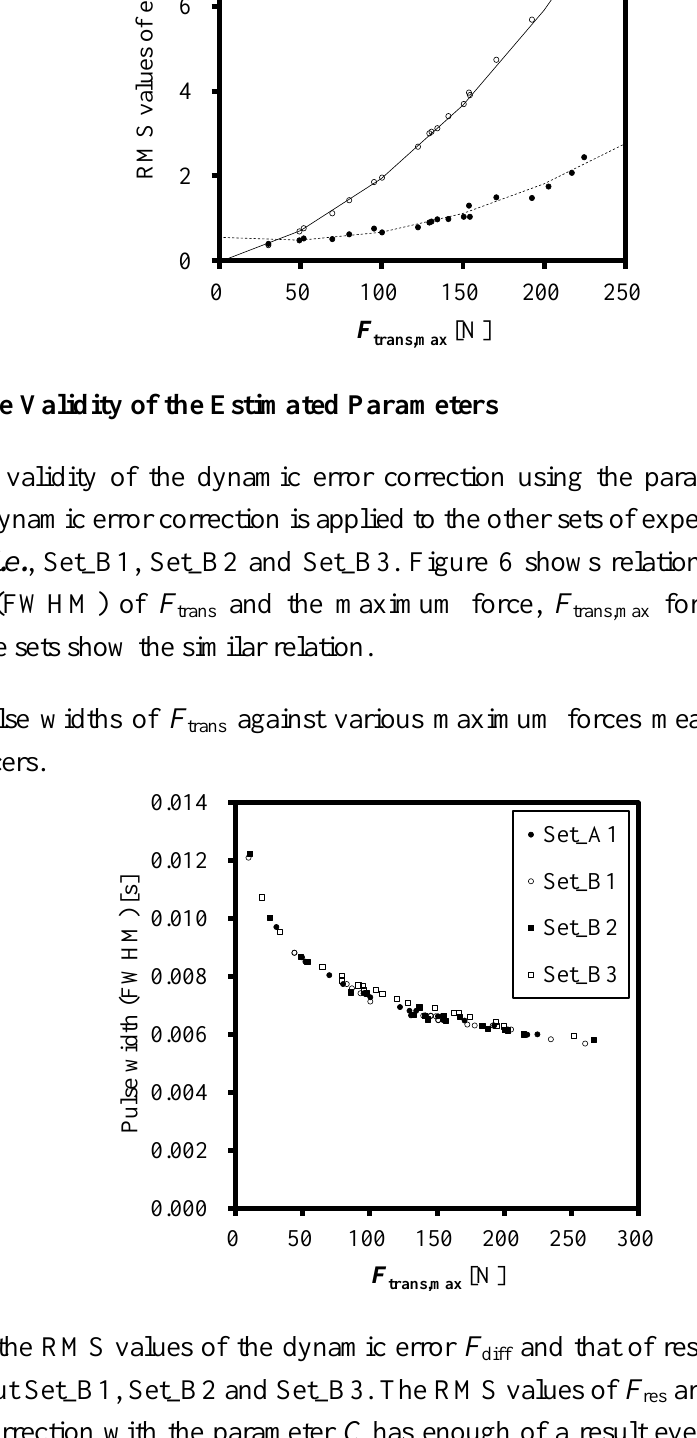
Figure 5. RMS valuses of the dynamic measurment error F values of the residual error of the corrected values F